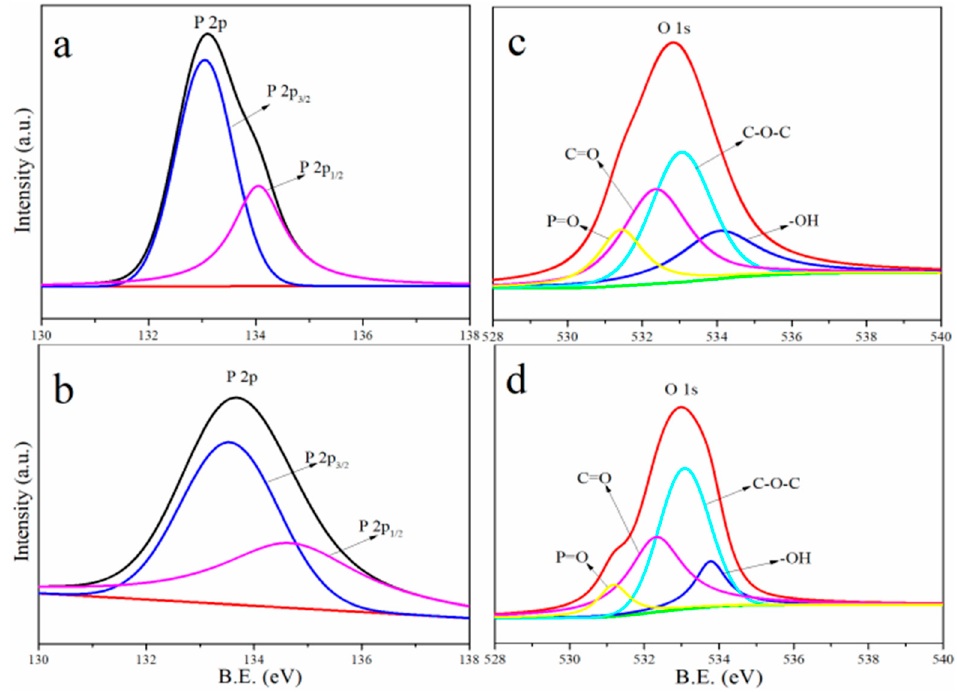
Figure 9. XPS spectra of P 2p for PVKAP before ( a ) and after ( b ) uranyl entrapment, O 1s for PVKAP before ( c ) and after ( d ) uranyl entrapment.